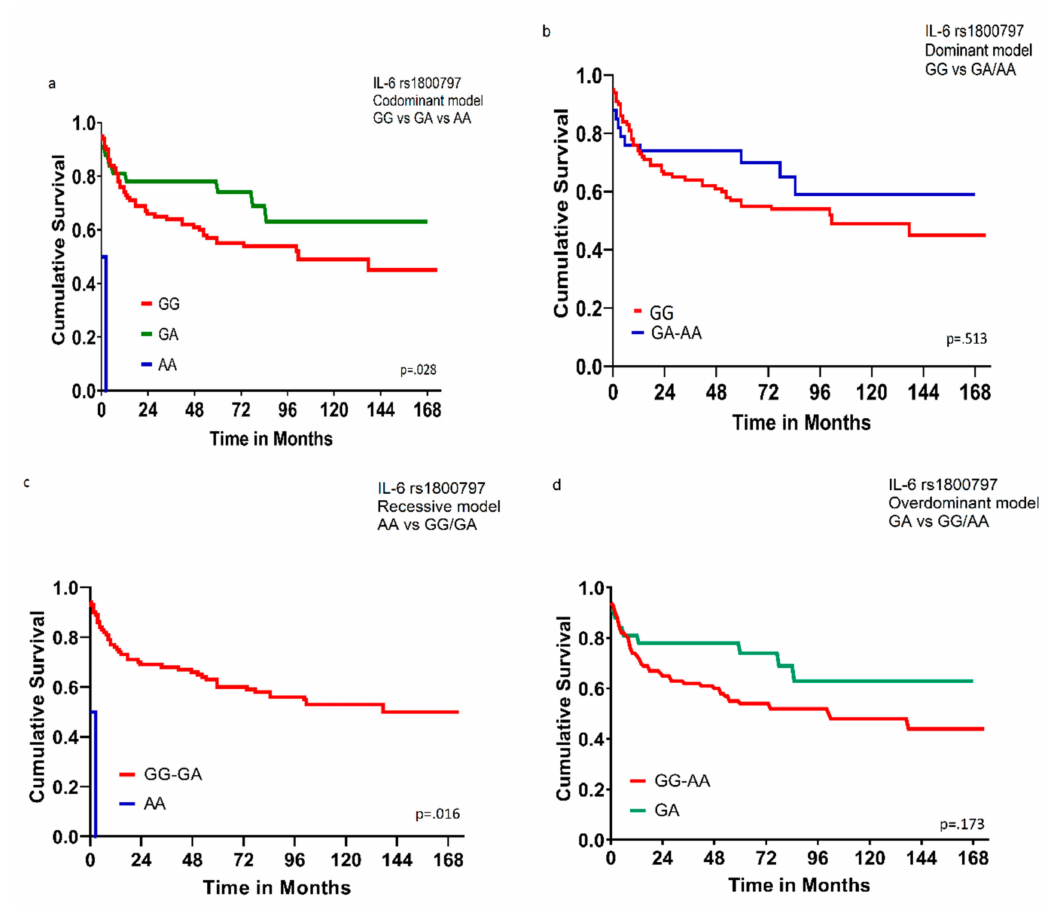
Figure 1. Overall survival for 125 DLBCL patients according to genotype of IL-6 rs1800797. ( a ) Comparison among GG, GA, and AA genotypes; codominant model ( p = 0.028). ( b ) Comparison between GG genotype and combined GA / AA genotypes; dominant model ( p = 0.513). ( c ) Comparison between AA genotype and combined GG / GA genotypes; recessive model ( p = 0.016). ( d ) Comparison between GA genotype and combined GG / AA genotypes; overdominant model ( p = 0.173). Wilcoxon (Gehan) Statistic p values were